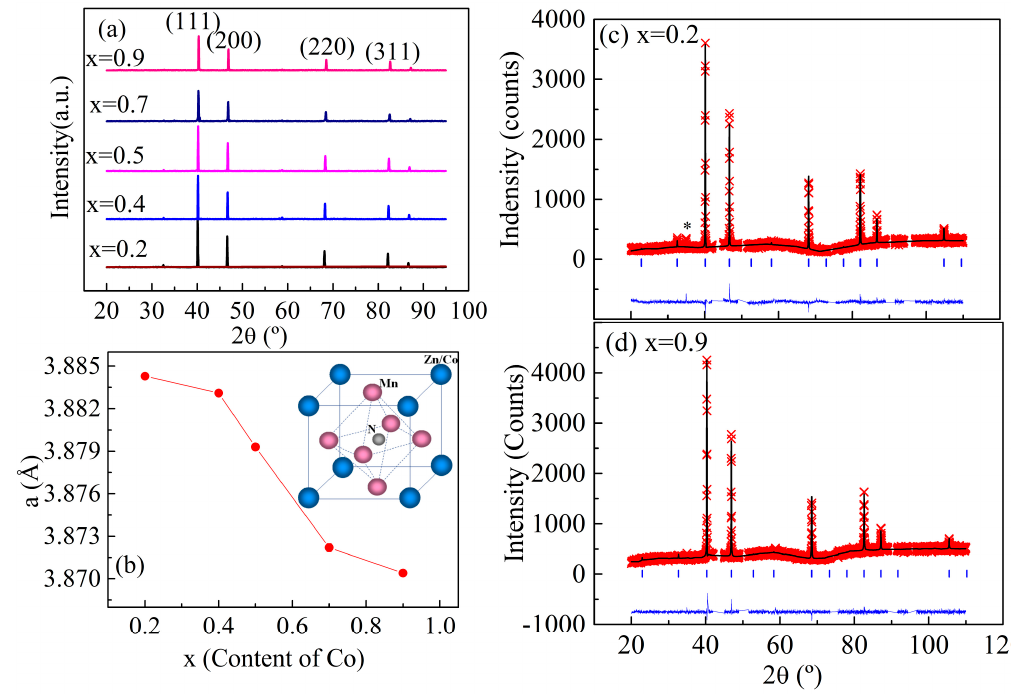
Figure 1. ( a ) Powder XRD patterns of the polycrystalline Mn 3 Zn 1 − x Co x N (0 ≤ x ≤ 1) at room temperature; ( b ) Lattice parameter as a function of the Co content. Inset shows the schematic crystal structure of Mn 3 Zn 1 − x Co x N; ( c , d ) Rietveld analysis of the XRD patterns for Mn 3 Zn 1 − x Co x N (x = 0.2 and 0.9) observed at room temperature. The cross marks and solid lines show the observed and calculated patterns, respectively. The difference between them is shown at the bottom of each panel. The positions of the Bragg reflections are marked by ticks. The symbol of asterisk indicates the impurity phase MnO. Excluded regions are the diffraction reflections from sample holder (Cu).